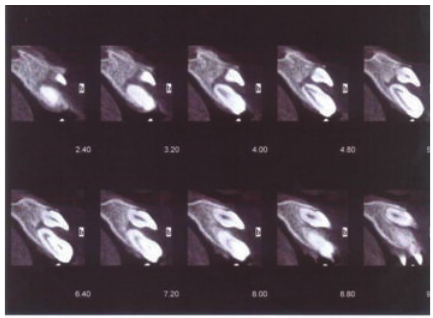
Figure 5: Cone beam computer imaging (CBCT) of lateral view depicting dilated odontoma.